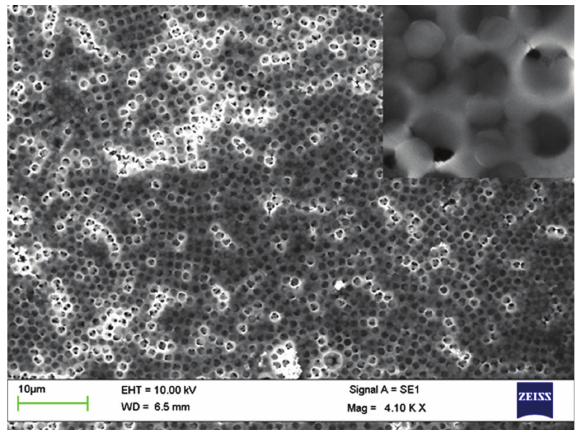
Figure 3: SEM image of S. cohnii in the microwells constructed from AgNPs. Inset image shows a closer caption of the bacterial cells.